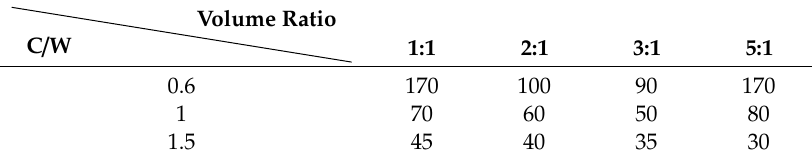
Table 2. Initial setting time of D3 grouting materials (s). C—cement; W—water. Volume C / W